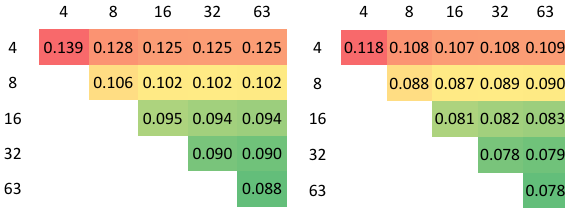
Table 2-3: RMSE (mm) in elevation of the DTM for all combinations of compression factors in the image pair. Left: 10° image pair; Right: 70° image pair